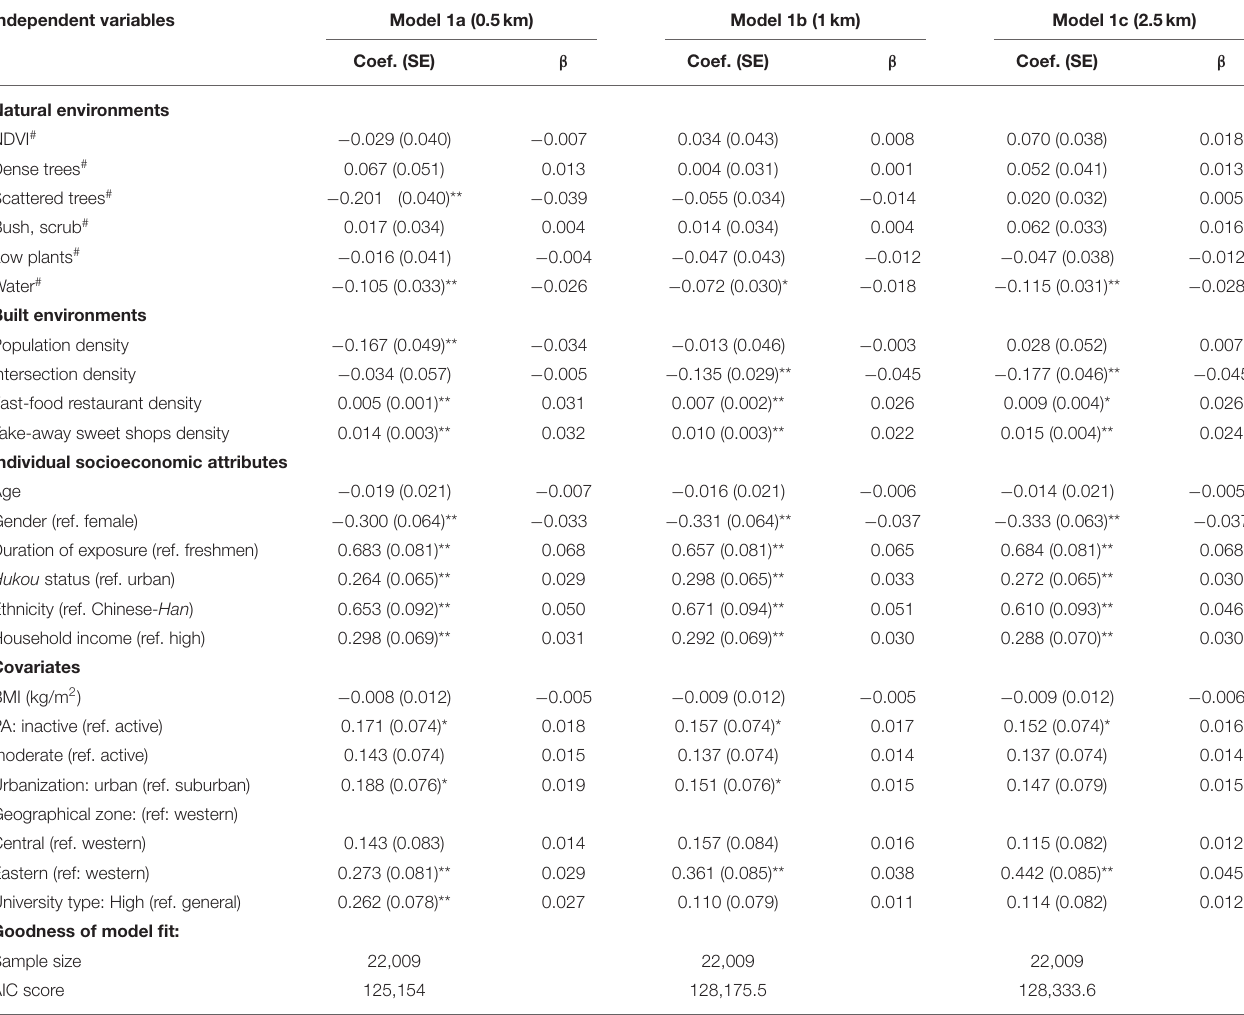
TABLE 3 | Results of multivariate linear associations between PHQ9-based depression and exposure to natural and built environments at multiple scales. Independent